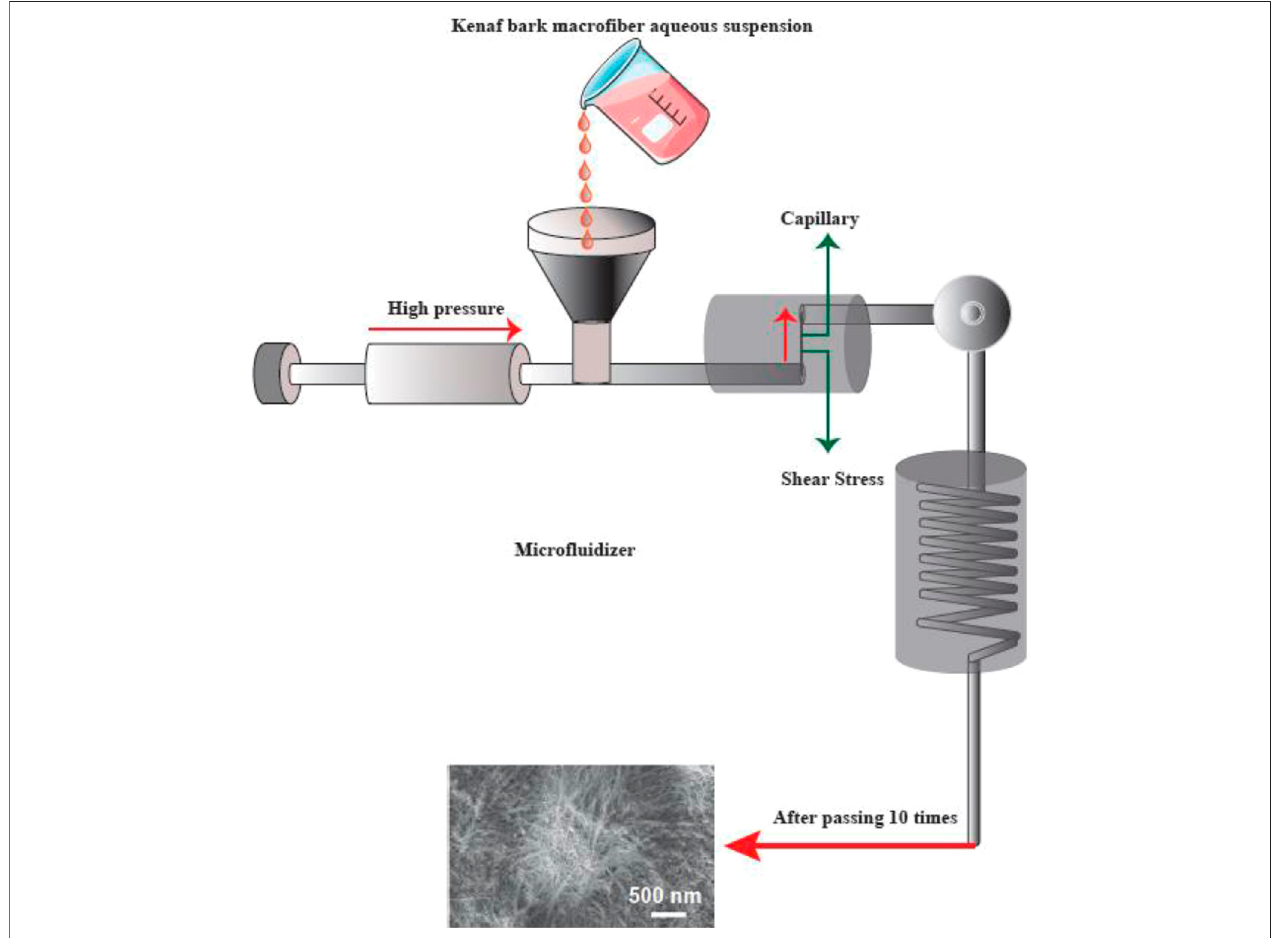
FIGURE 6 | The apparatus for grinding, and SEM images (A) prior to and (B) following the grinding into re fi ned macro- fi bers (scale bar: A. 1,000 μ m and B. 1 μ m). This fi gure adapted from Nishino et al. (Nishino 2017).